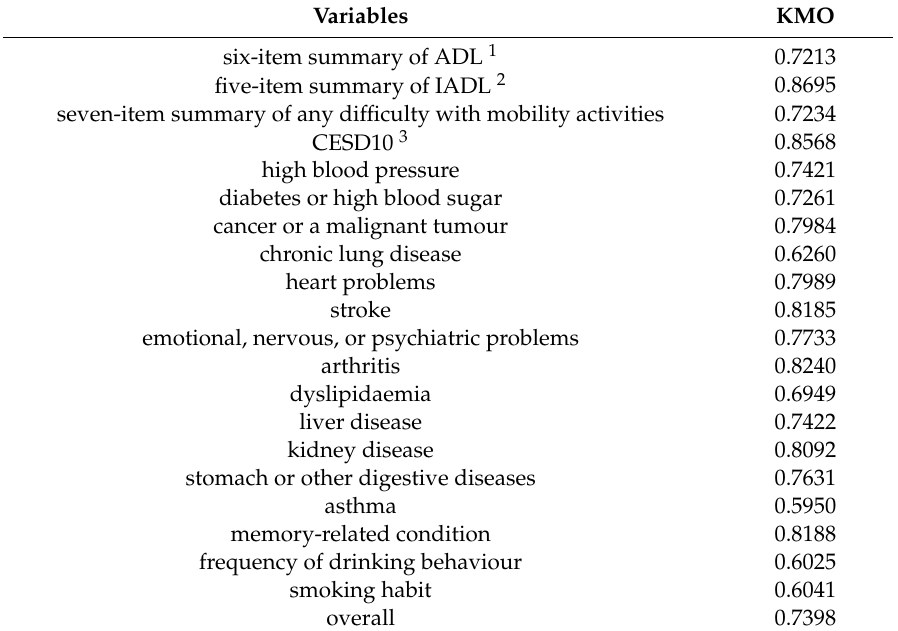
Table A1. KMO (Kaiser-Meyer-Olkin) value of variables selected in Harmonized CHARLS to employ factor